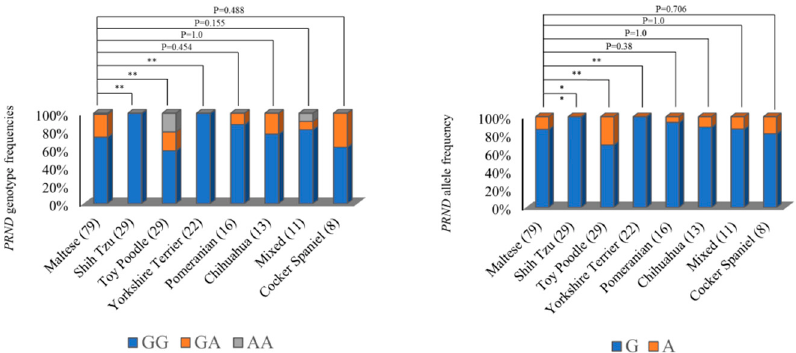
Figure 2. Comparisons of genotype and allele frequencies of c.149G>A (R50H) among eight dog breeds. Differences in the c.149G>A (R50H) genotype and allele frequencies among eight dog breeds (Maltese, Shih Tzu, Toy Poodle, Yorkshire Terrier, Pomeranian, Chihuahua, Cocker Spaniel, and Mixed dogs) were calculated by the chi-square test using Statistical Analysis Software (SAS) version 9.4. Parentheses indicate the number of dogs. Statistically significant differences are indicated below. * p value < 0.05, ** p value < 0.01, *** p value < 0.001.